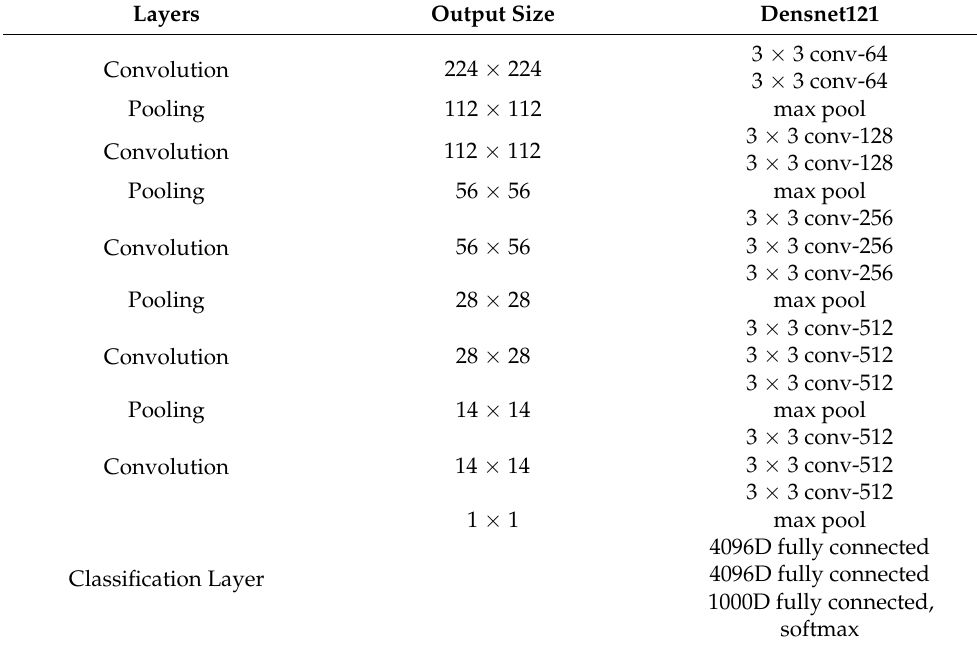
Table 5. VGG16 construction.